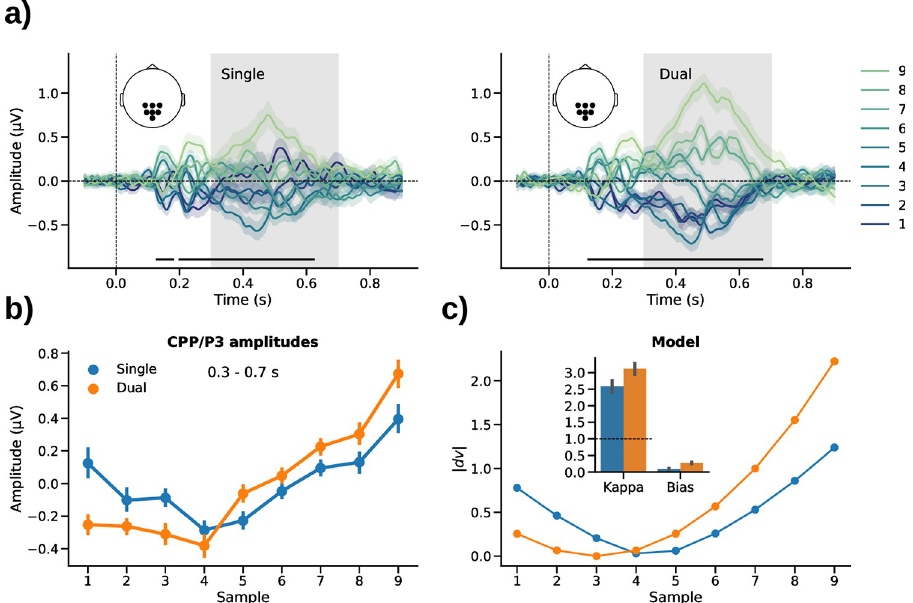
Fig 4. Univariate CPP/P3 results. a) Centro-parietal ERPs (mean-subtracted) evoked by sample values 1–9 in the single- ( left ) and dual-stream ( right ) tasks. Marker lines on bottom indicate significant differences between the 9 different sample values (p cluster < 0.001, repeated measures analysis of variance). b) Mean CPP/P3 amplitudes averaged over the time window outlined by gray shading in a (0.3–0.7 s). c) Neurometric model fit of CPP/P3 amplitudes. Line plot shows grand mean fit. Inset bar graph shows mean parameter estimates. Error indicators in all panels show